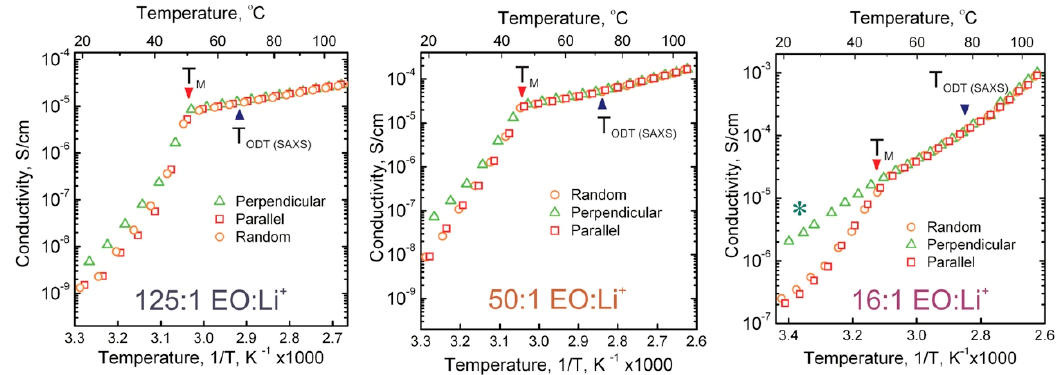
Figure 9. Temperature dependence of conductivities for perpendicular, parallel and random PEO lamellae at 125:1, 50:1 and 16:1 EO:Li + stoichiometries, as indicated. T M and T ODT mark the locations of PEO melting and the order-disorder transition inferred from DSC and SAXS data respectively. *Note in the case of the 16:1 perpendicular lamellae that the PEO remained amorphous during the measurement.